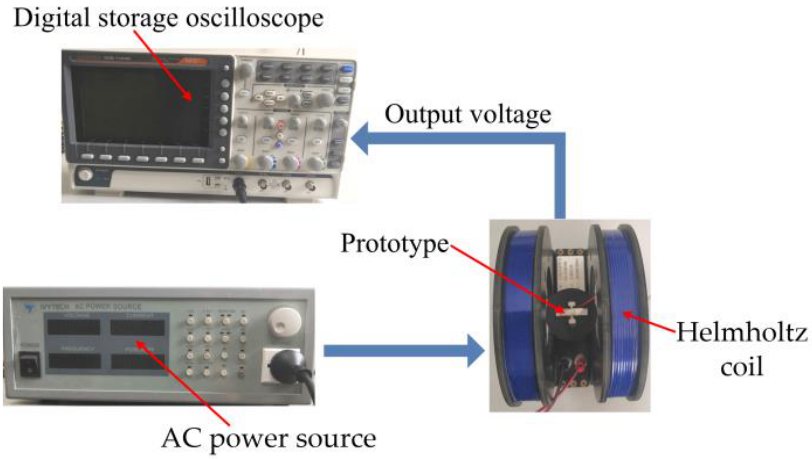
Figure 3. Measurement principle for the induced voltages of the fabricated prototype.